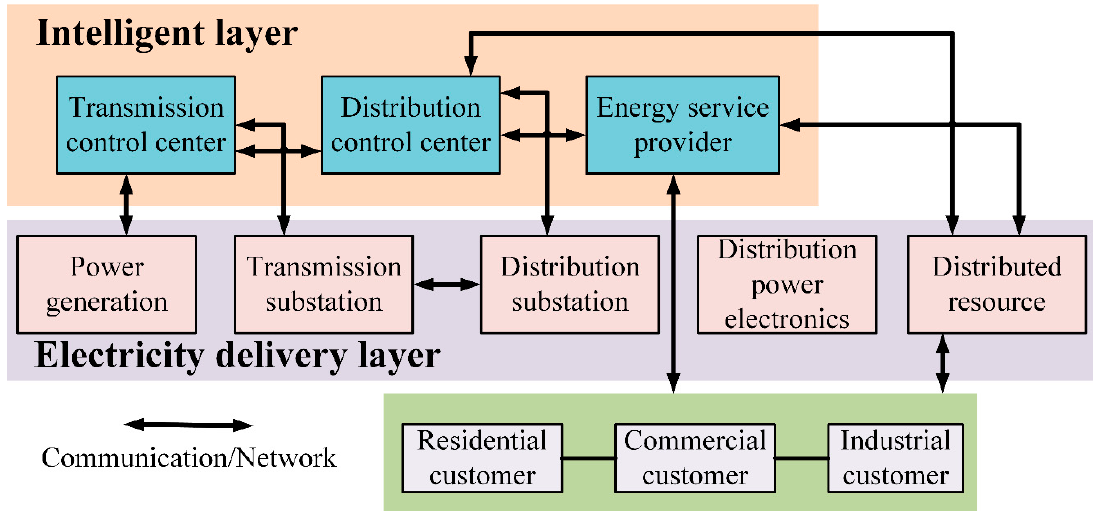
Figure 8. ICT infrastructure of SG. It consists of intelligent layer and electricity delivery layer. This layer-based ICT infrastructure is capable of avoiding illegal access and protecting against cyber-attack.